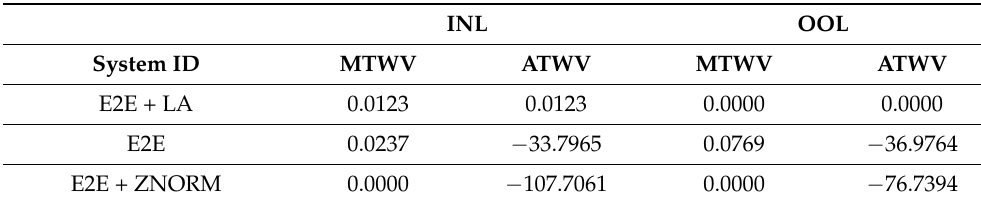
Table 25. System results of the QbE STD task for SPARL20 test data for in-language (INL) and out-of-language (OOL)